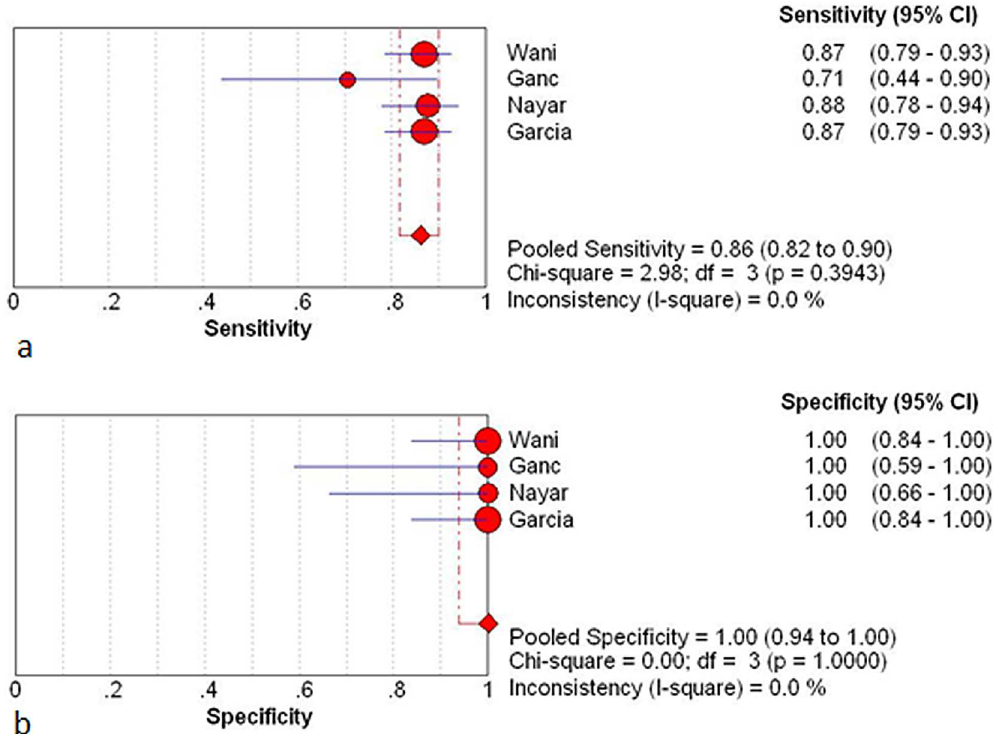
Fig 7. Results for the non-ROSE group in individualstudies and from pooleddata shown as forest plots for: a sensitivity; b specificity. The I 2 result for heterogeneity is also stated (CI, confidenceinterval; df, degrees of freedom).